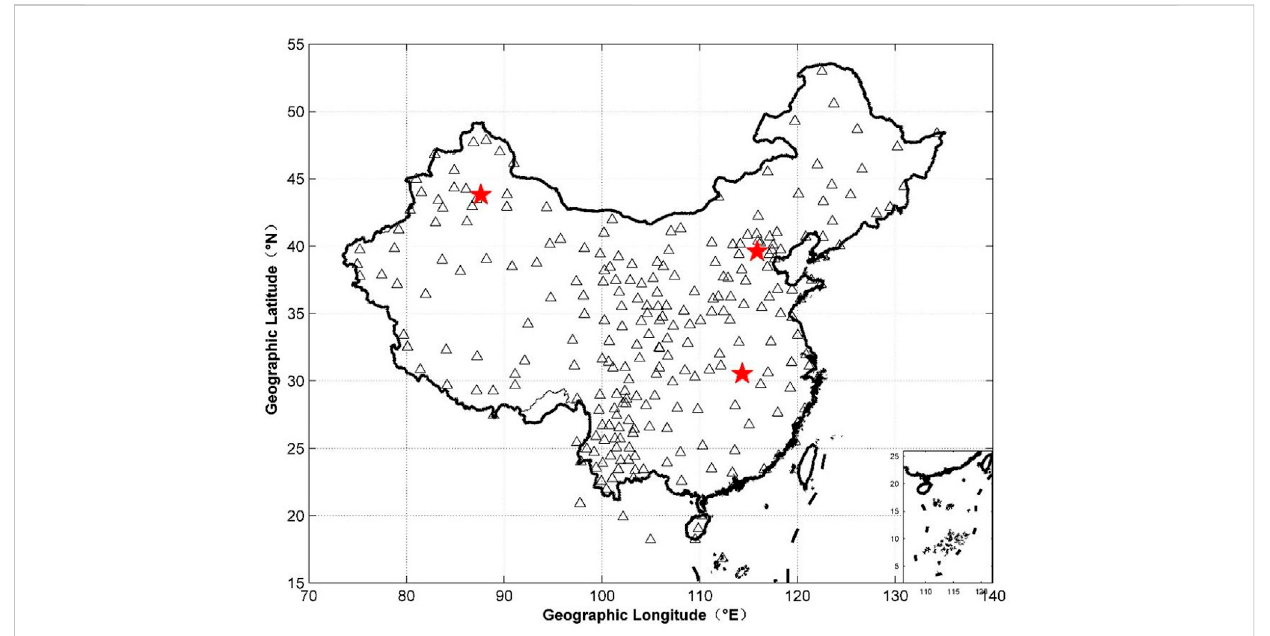
FIGURE 1 The distribution of 260 continuous GNSS stations (triangles) and 3 IGS GNSS stations (red pentacles) in